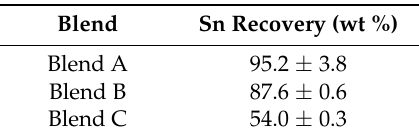
Table 3. Tin recovery via the pyrometallurgical reduction smelting process depending on the type of mixture